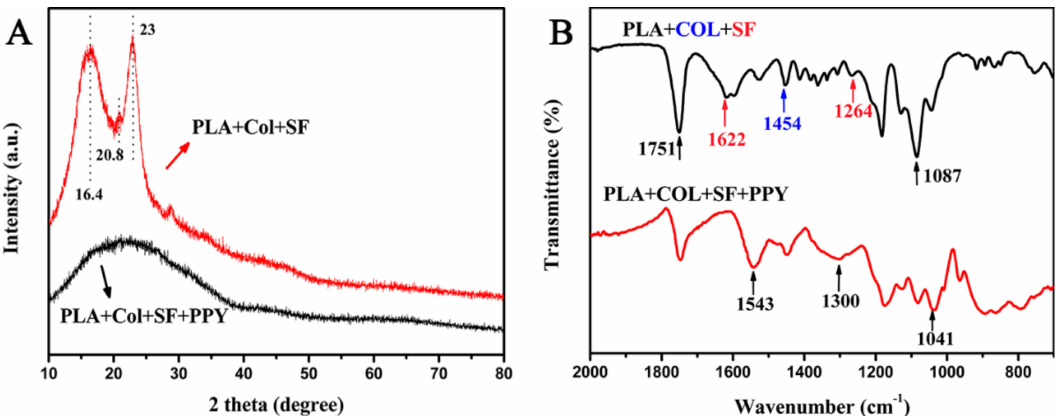
Figure 2. X-ray diffraction (XRD) patterns ( A ) and Fourier transfer infrared spectroscopy (FTIR) spectra ( B ) of PLA–SF–COL nanofiber mats before and after PPy modification, respectively.